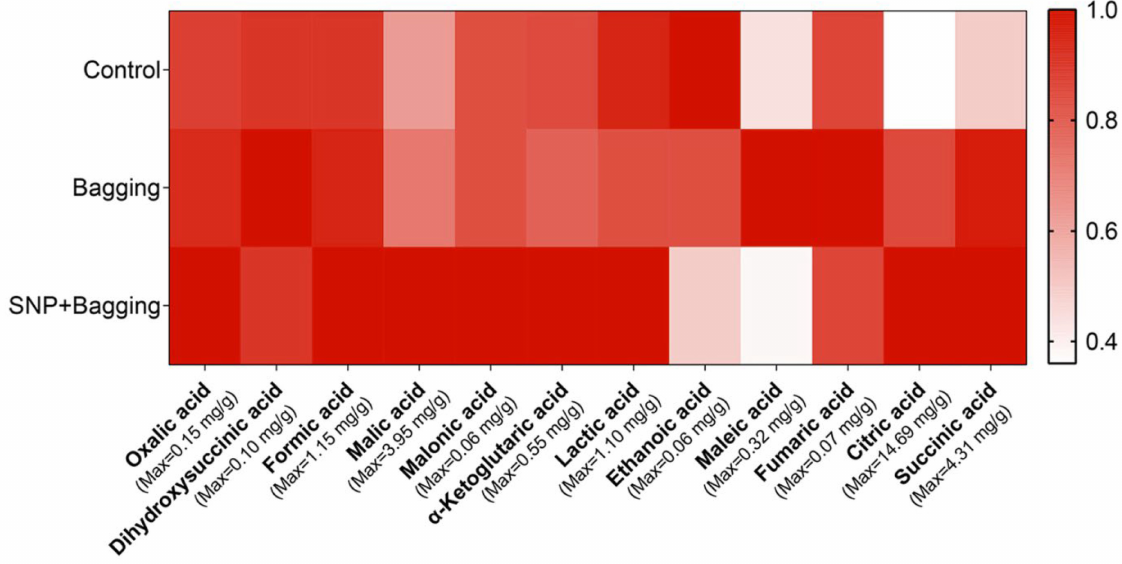
Figure 5. Heatmaps of organic acids in blood orange fruits after different treatments. The bar represents the relative value (measured value/max value ×